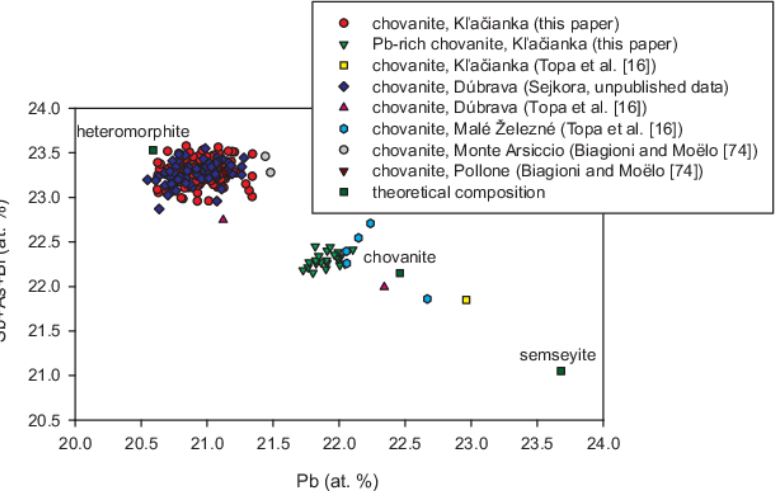
Figure 14. Chemical composition of chovanite in the graph Pb vs. Sb + As + Bi (at.%); theoretical composition: heteromorphite Pb 7 Sb 8 S 19 , chovanite Pb 15-2x Sb 14+2x S 36 O x ( x = 0.2), and semseyite Pb 9 Sb 8 S 21 ; for Tl-containing samples from Monte Arsiccio and Pollone mines, the Pb corr and Sb corr data (Biagioni, Moëlo [74]) are used.